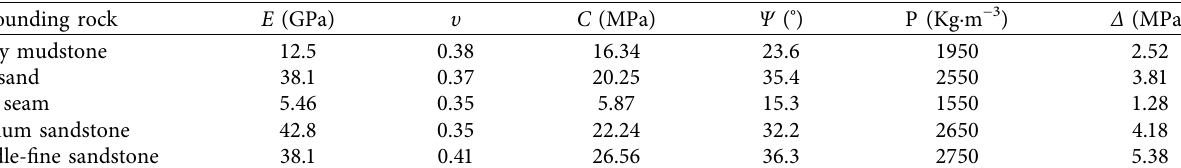
Table 1: Material parameters of each stratum in the model.